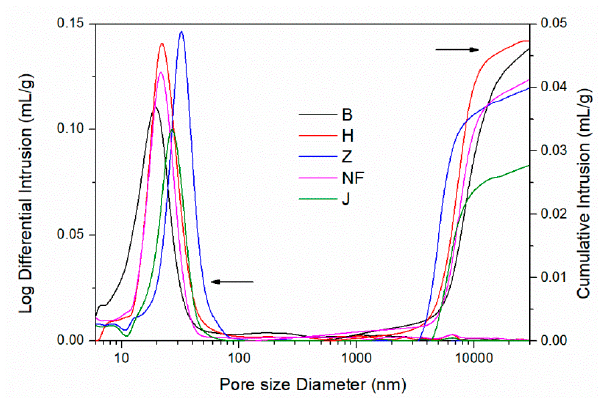
Figure 8. Effects of different superplasticizers on the cumulative pore volume of the cement paste.